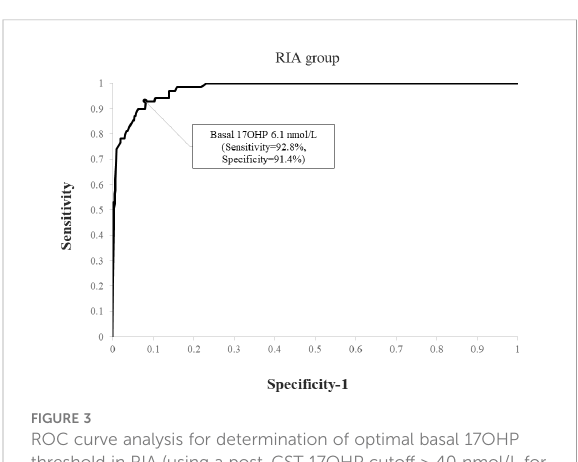
FIGURE 1 ROC curve analysis for determination of optimal basal 17OHP